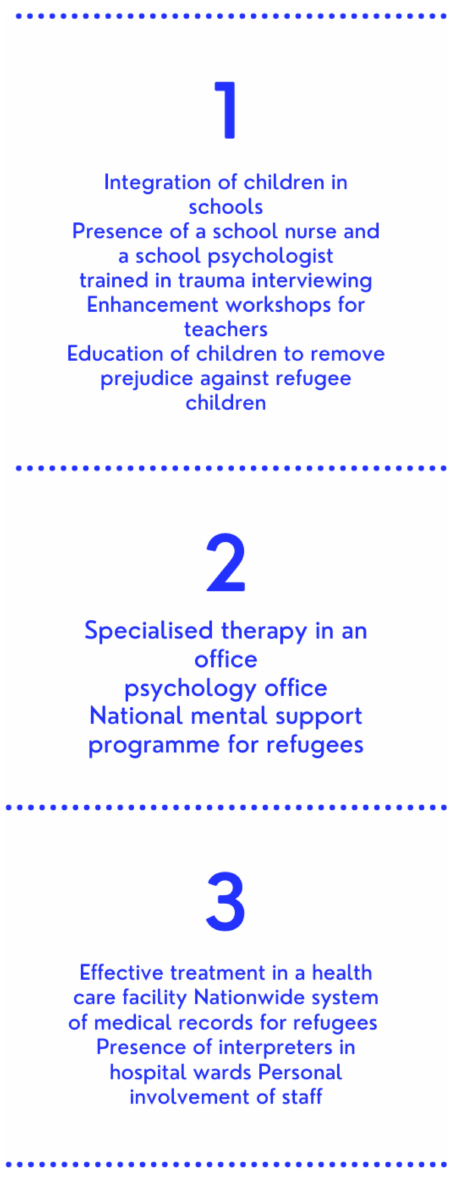
Figure 4. Proposal for a three-step system to improve communication between paediatric patients and medical